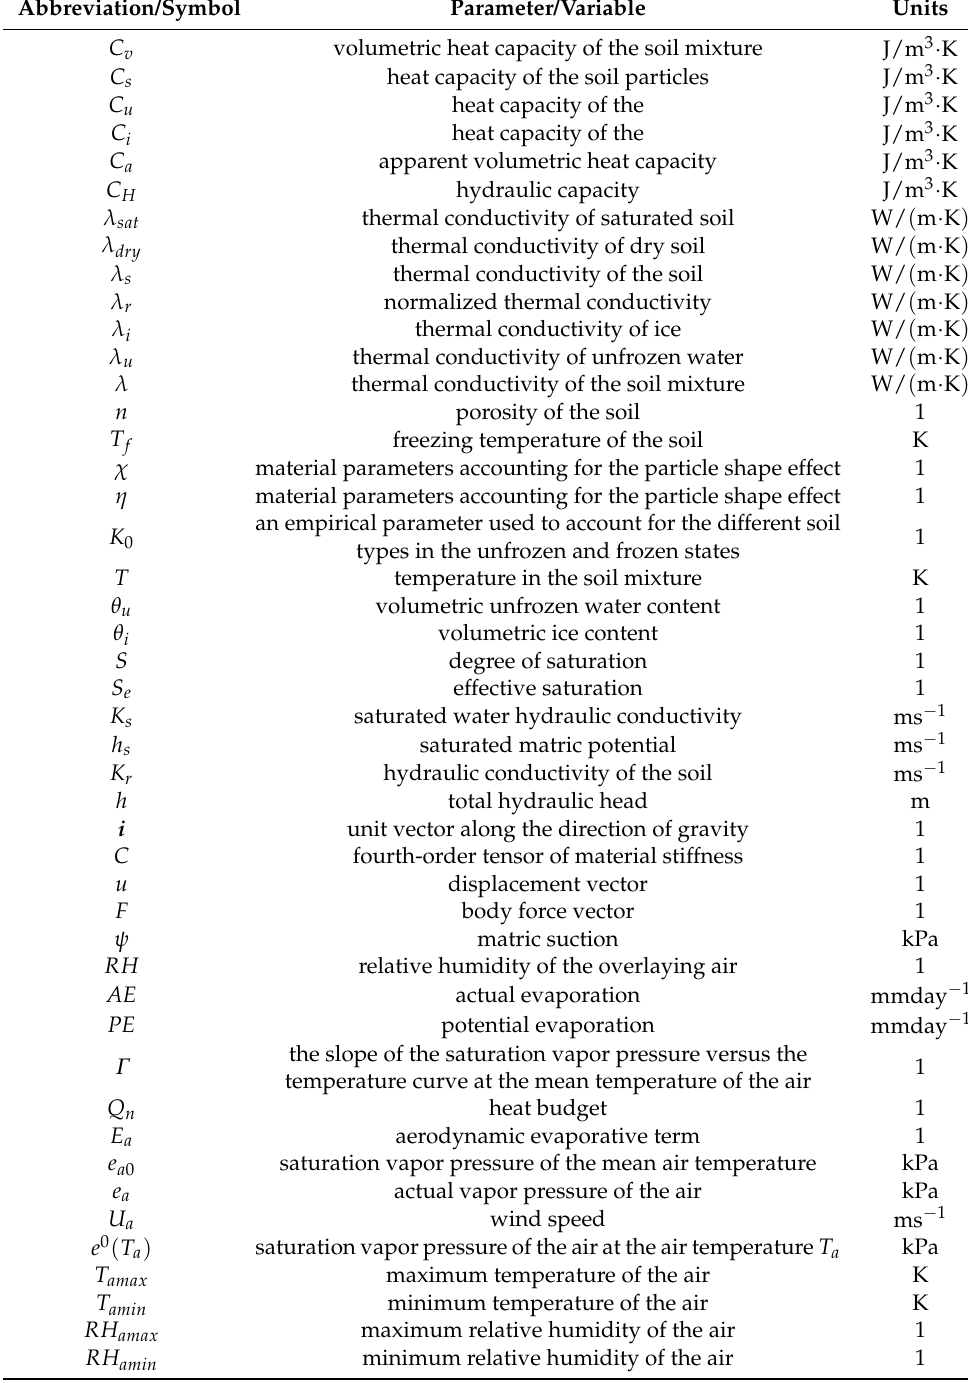
Table 1. List of